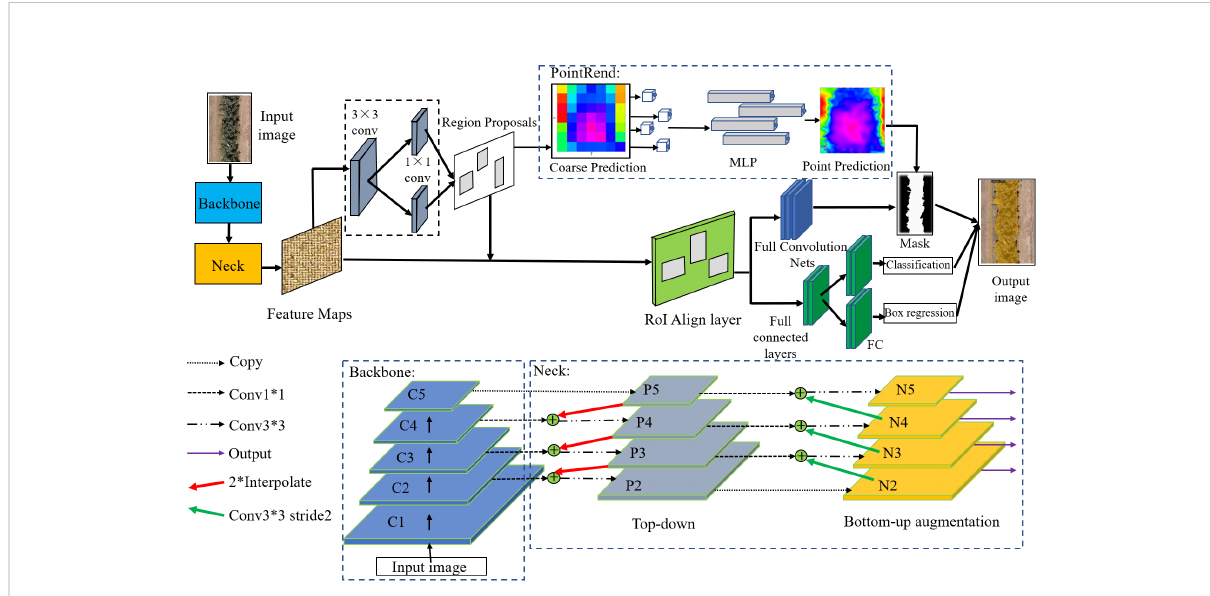
FIGURE 4 Canopy segmentation model base on Mask R-CNN. * indicates that the height and width of the convolution kernel matrix are multiplied.